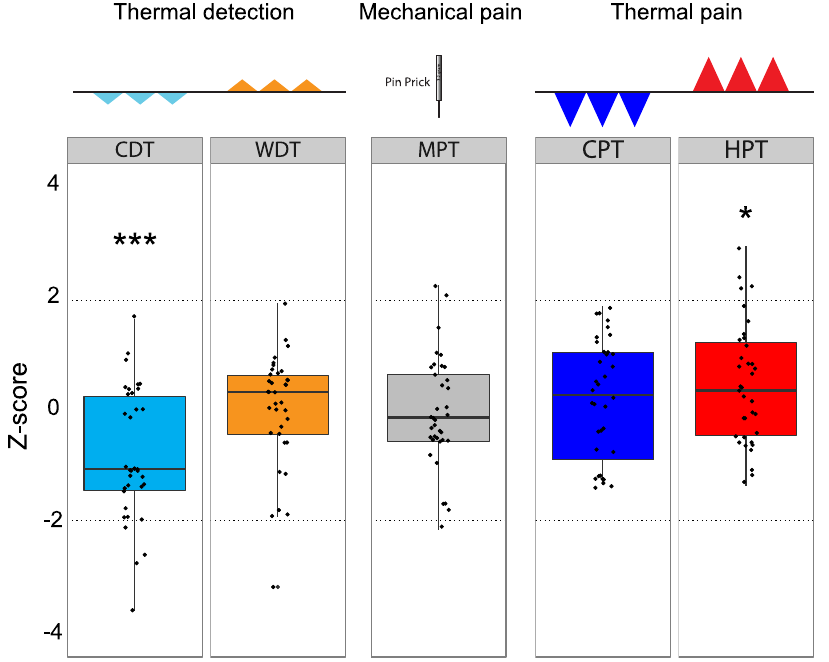
Figure 4. Sensory profiles in the hearing impaired cohort (n = 36). The z-values were normalized for gender on the z-scale. The z-scores for each deaf subject are represented as dot and box plots. Z-scores between 1.96 and − 1.96 represent the normal range of healthy controls (n = 111). Z-scores > 0 indicate increased sensitivity to presented stimuli or in case of pain stimuli, lowered pain threshold. Z-scores < 0 indicate decreased sensitivity to presented stimuli, or in case of pain stimuli, higher pain threshold. * P < 0.05, ** P < 0.01, *** P < 0.001, ANOVA. CDT, cold detection threshold; CPT, cold pain threshold; HPT, heat pain threshold; MDT, mechanical detection threshold; MPT, mechanical pain threshold; WDT, warm detection